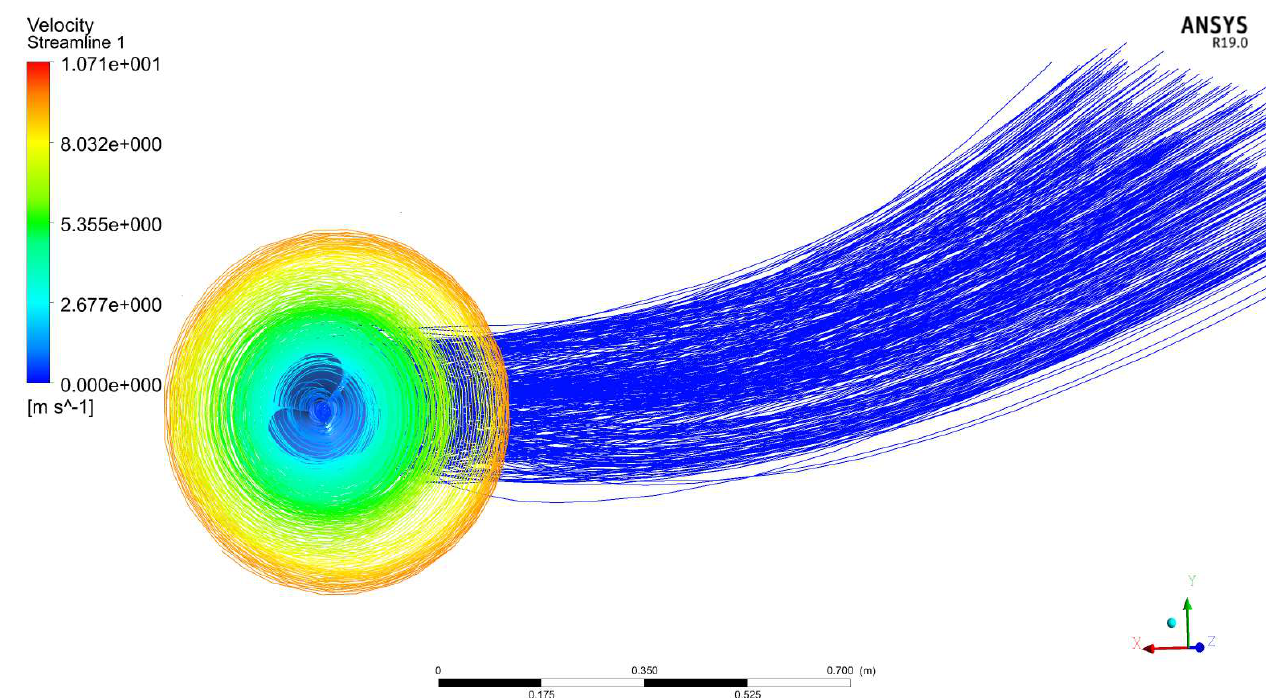
Figure 17. Velocity variations of 300 RPM.